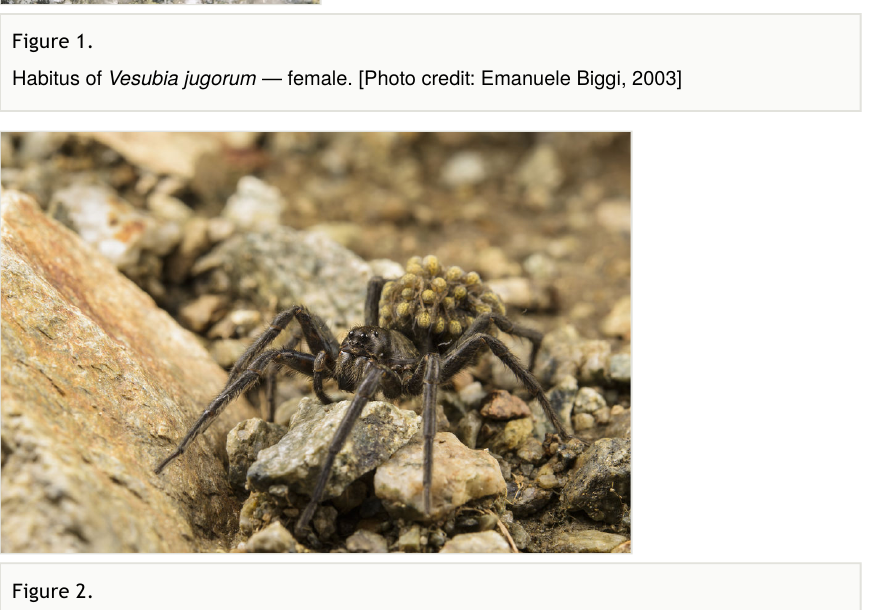
Vesubia jugorum — female with spiderlings. [Photo credit: Emanuele Biggi,